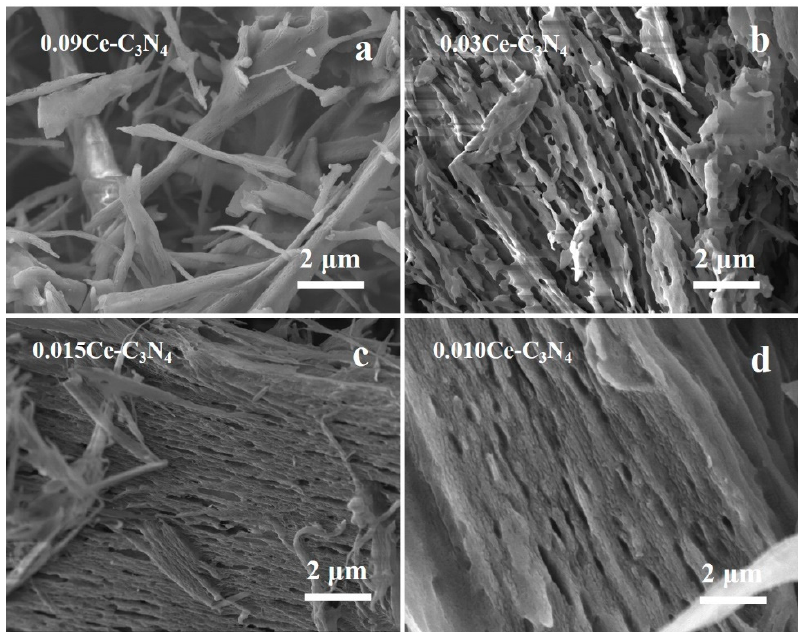
Figure 5. High-magnification SEM images of ( a ) 0.090Ce-C 3 N 4 , ( b ) 0.030Ce-C 3 N 4 , ( c ) 0.015Ce-C 3 N 4 , and ( d ) 0.010Ce-C 3 N 4 . Nanomaterials 2019 , 9 , x FOR PEER REVIEW